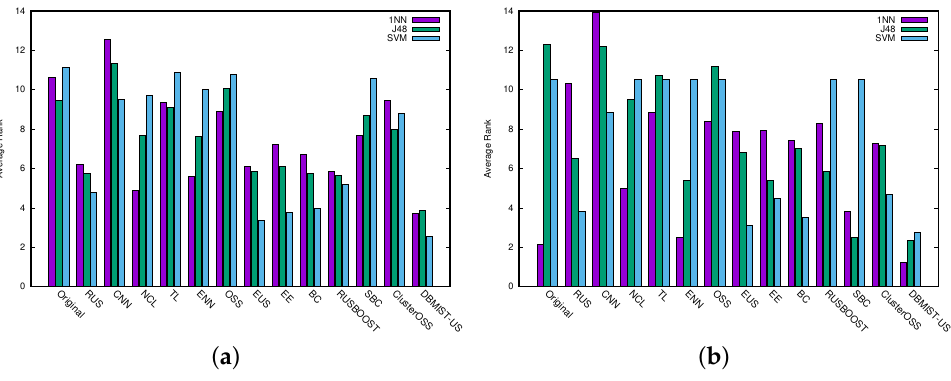
Figure 3. Comparison of average Friedman ranks. ( a ) real data sets; ( b ) synthetic data